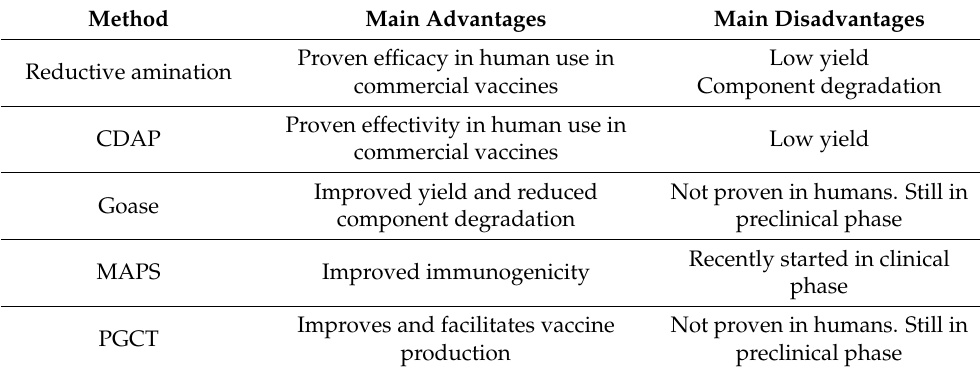
Table 2. Main advantages and disadvantages of currently conjugation techniques used in pneumo- coccal